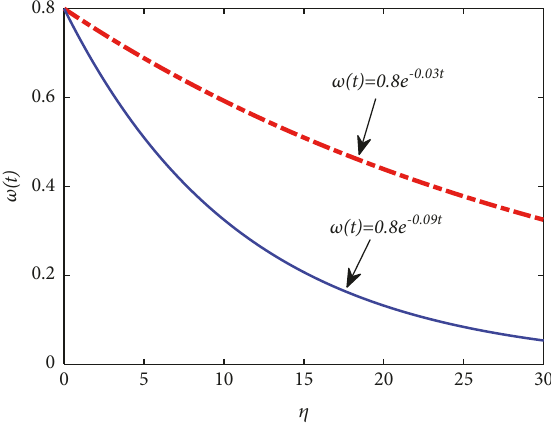
Figure 1: The effect of the initial fashion level on fashion level.